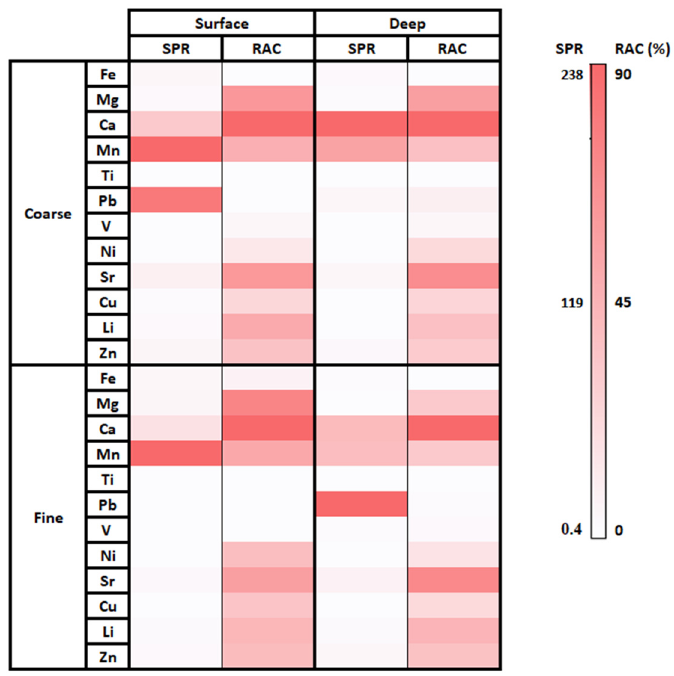
Figure 6. Secondary–primary phases ratio (SPR) and RAC values.